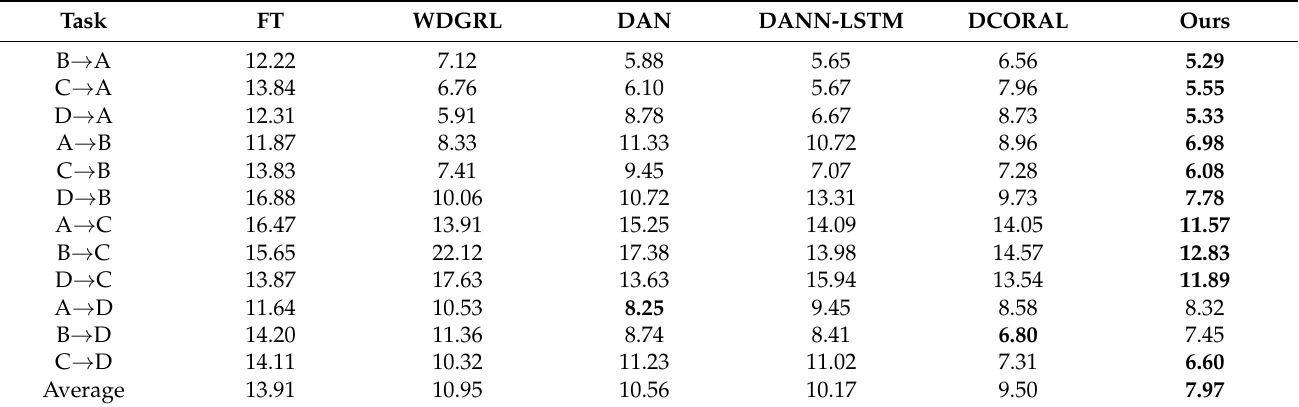
Table 5. MAPE Performance. The best performance of each task is highlighted in